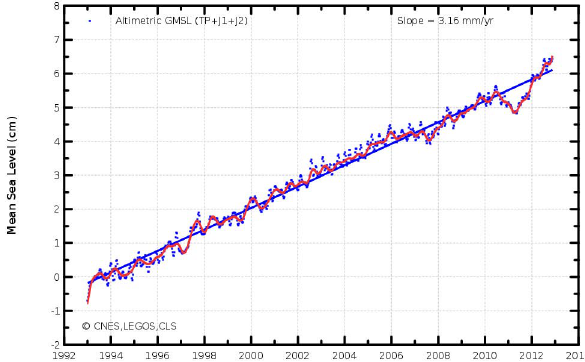
Fig. 3. Mean sea level variations over the 1992–2012 time period. The rise in mean sea level has been estimated as 3.17mmyr − 1 . Analysing the uncertainty of each altimetry correction made for cal- culating the GMSL, as well as a comparison with tide gauges gives an error in the GMSL slope of approximately 0.6mmyr − 1 with a 90% confidence interval. (Credits